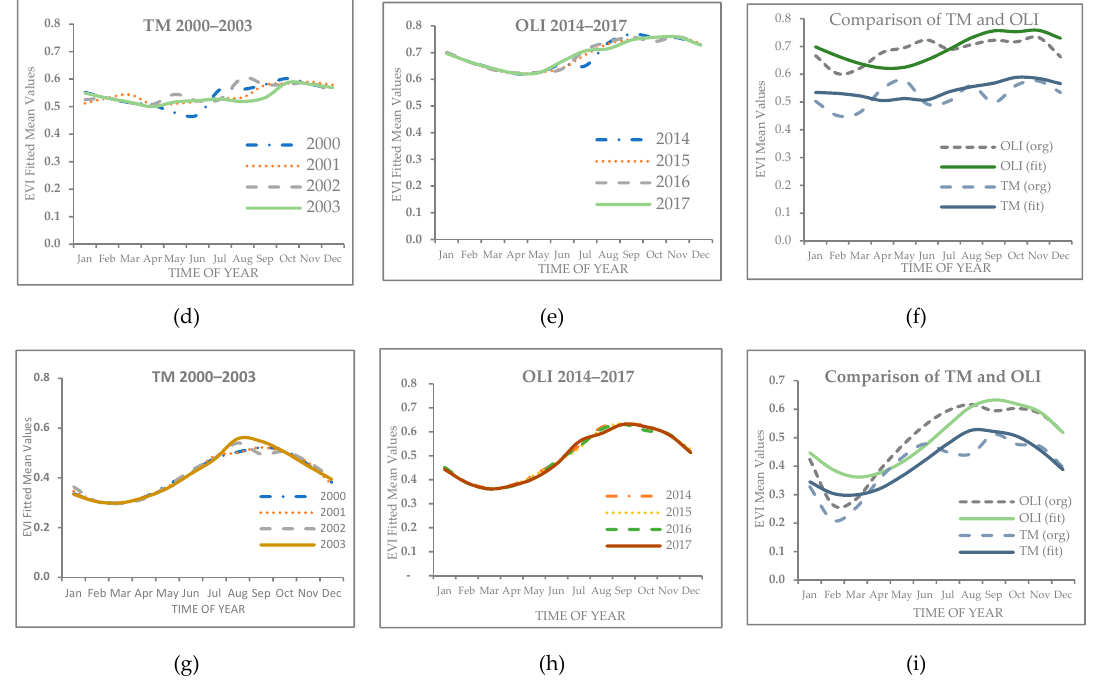
Figure 5. Example of monthly phenology profile of forest category vegetation index characteristics of Landsat TM and OLI data between 2000–2003 and 2014–2017. ( a ) TM of the average monthly fitted EVI profiles of evergreen (EG) trees from 2000–2003; ( b ) Landsat OLI of the average monthly fitted EVI profiles of EG trees from 2014–2018; ( c ) comparison of the original and fitted annual mean EVI profiles of EG forest produced by OLI and TM. ( d ) TM monthly average EVI profiles of semievergreen (SEG) trees; ( e ) OLI monthly average EVI profiles of SEG trees ; ( f ) the difference between annual mean EVI original and fitted EVI profiles of SEG forest produced by OLI and TM; ( g ) TM deciduous (DD) forest phenology spectral behaviors; ( h ) OLI monthly EVI phenology behaviors of DD forests; and ( i ) comparison of the annual mean EVI phenology profiles of DD forest produced by TM and OLI. We generated 722 phenological graphs to validate the phenological behaviors of selected land cover categories at the start-of-season (SOS) and end-of-season (EOS) and during the leaf-shedding (LSP) and leaf-flushing (LFP) periods.